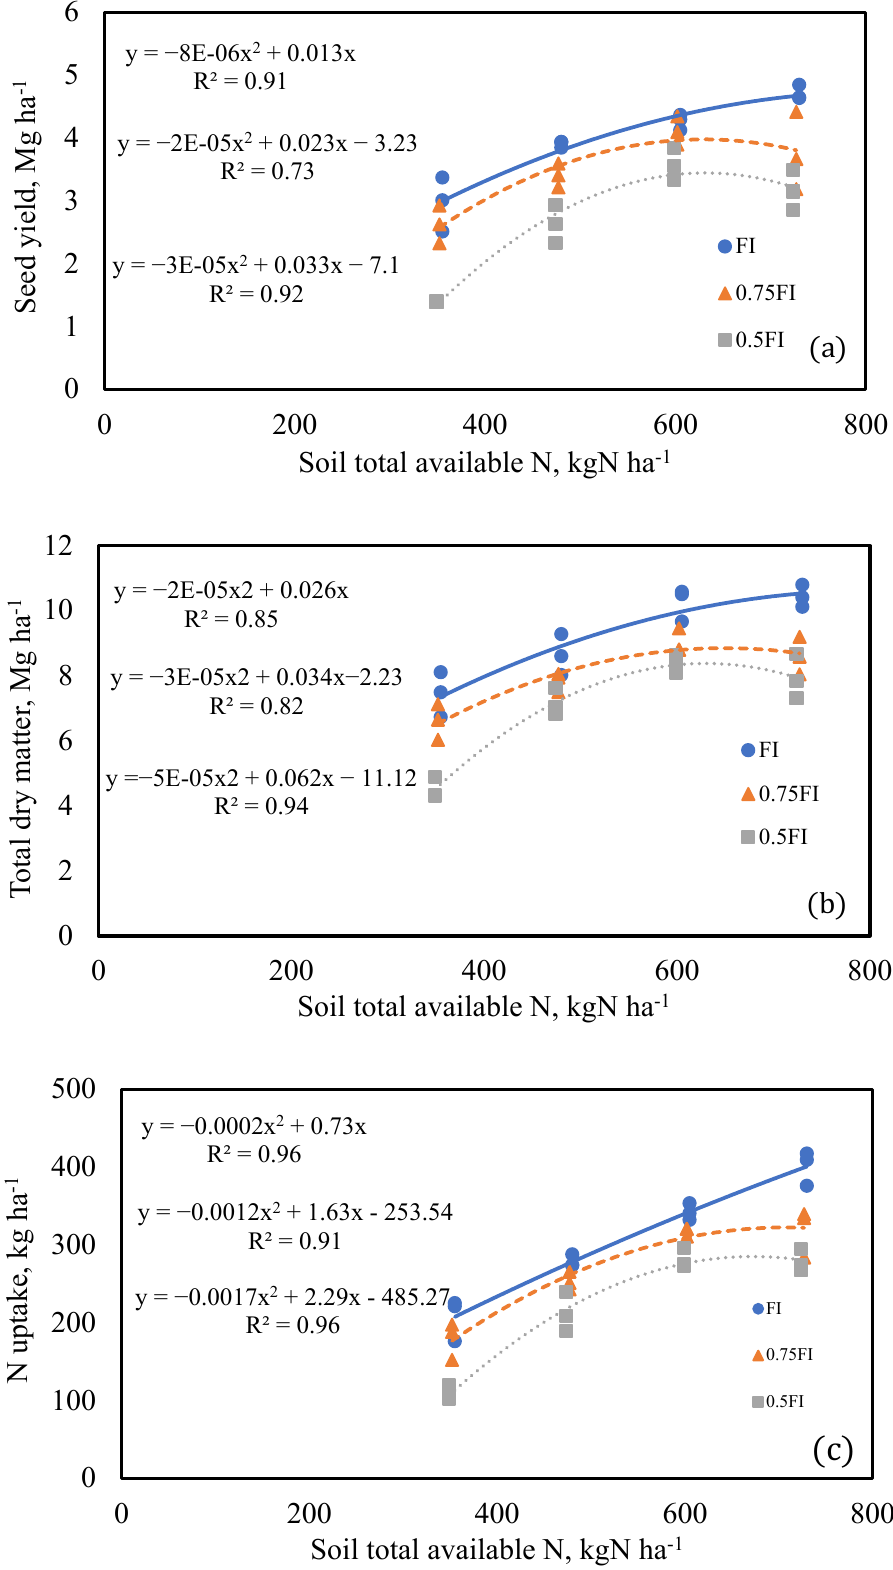
Figure 4. The relationship between soil total available N and quinoa seed yield, dry matter, and crop N uptake.